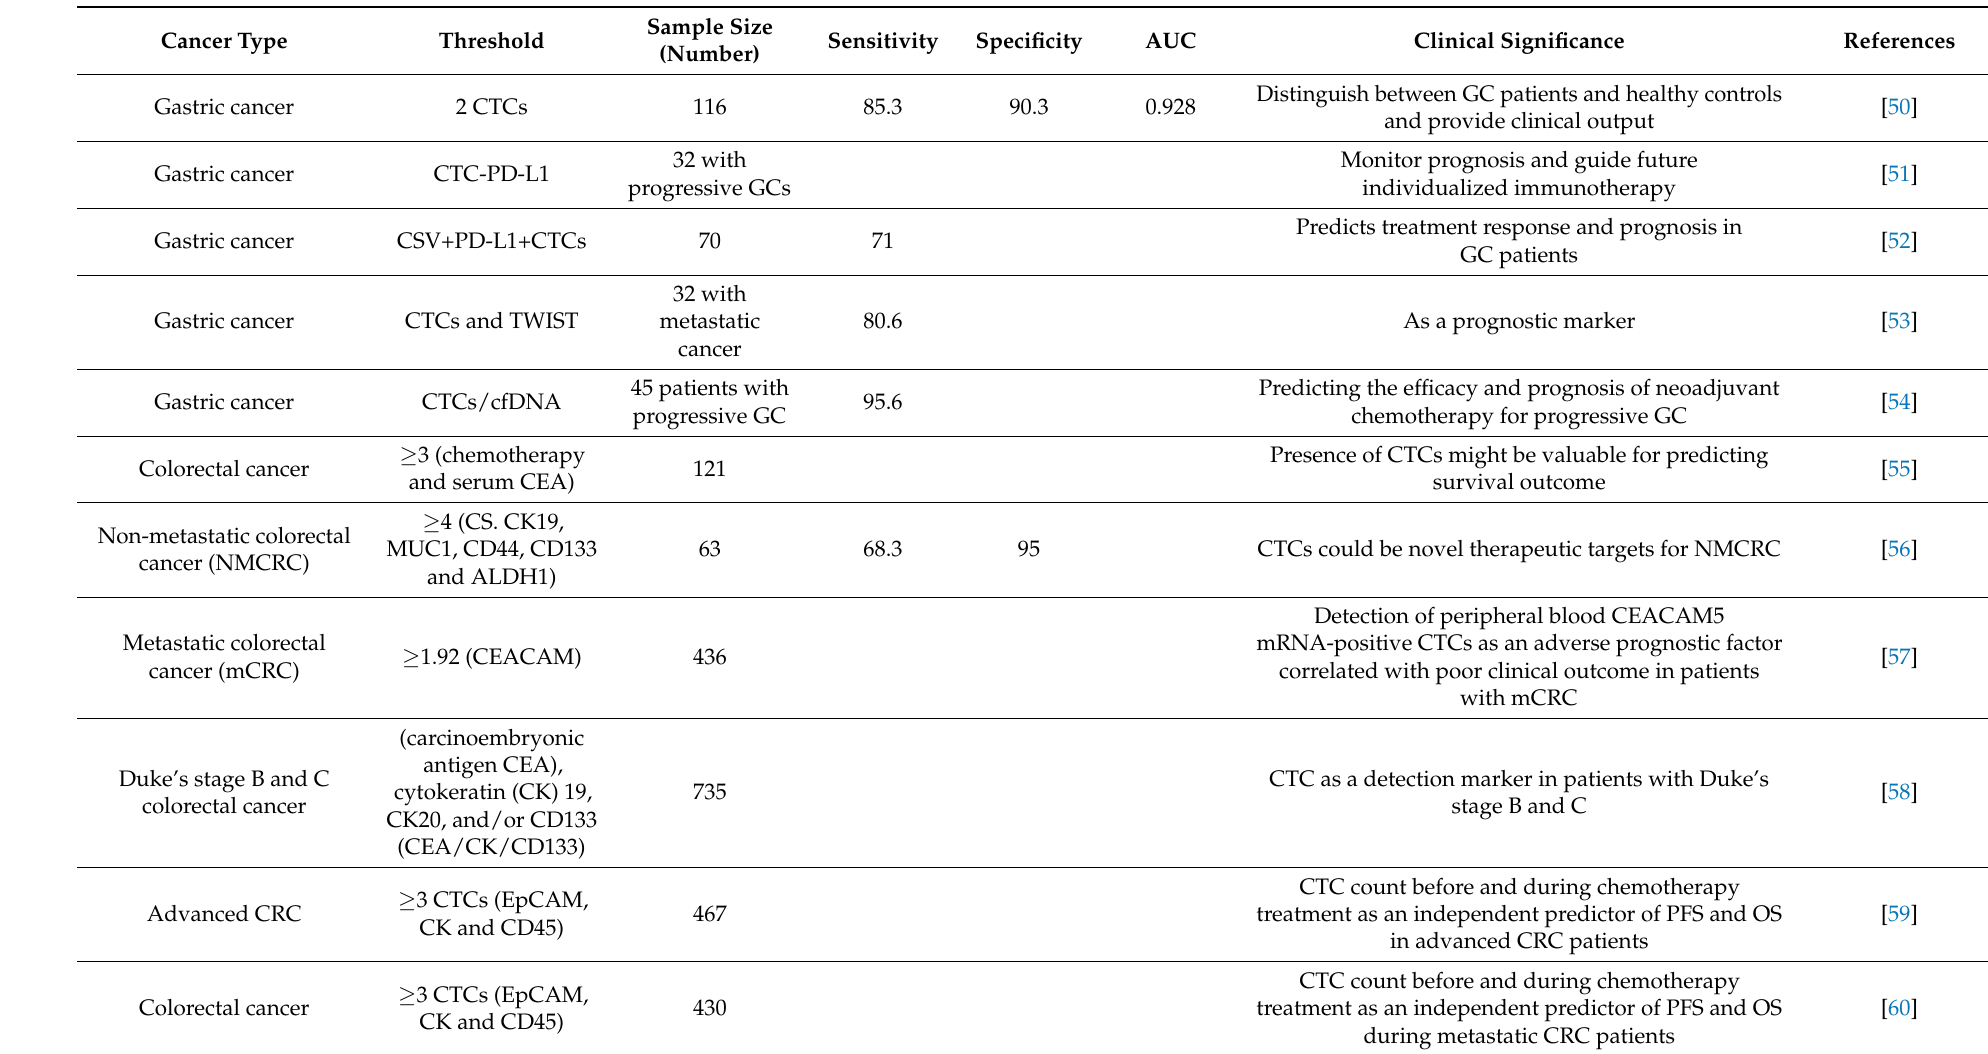
Table 1. Clinical relevance of CTCs in